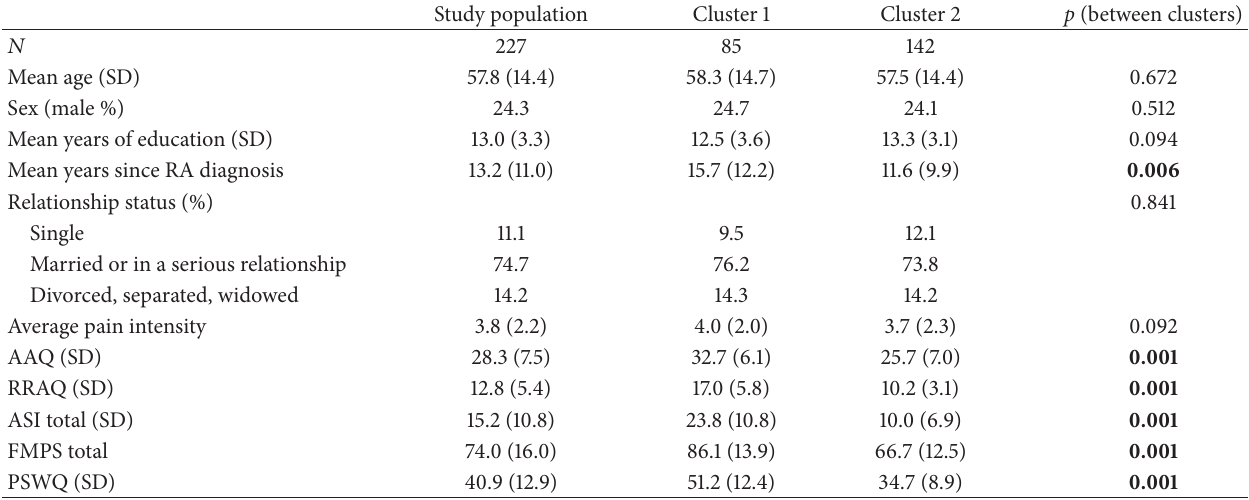
Table 1: Demographic and clinical characteristics of study sample and cluster subgroups.